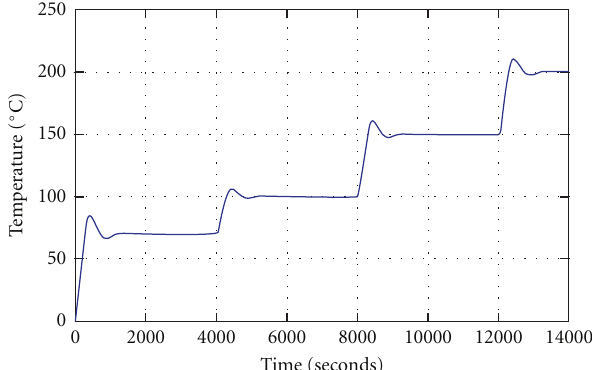
Figure 14: PID control simulated output at di ff erent temperature set points.